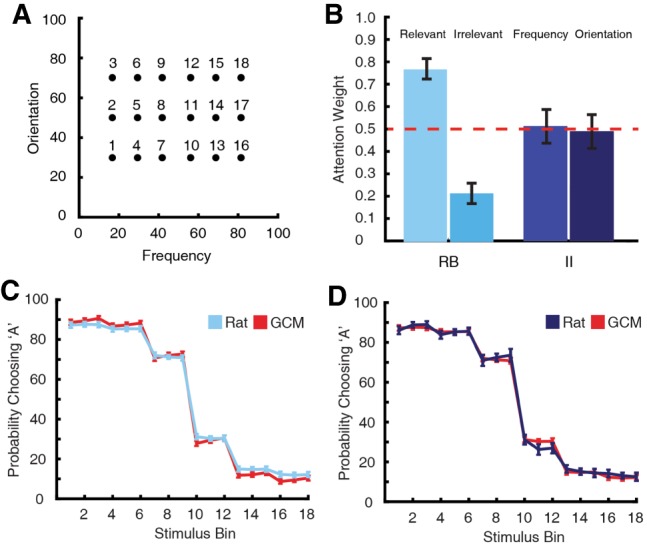
The GCM was fit to the generalization data of Experiment 1. (A) First, the testing distributions were averaged into 18 stimulus bins. This included three bins per trial type and nine bins per category. For each bin, the proportion of trials the rat responded category “A” was calculated. (B) The estimated attention weights obtained from the GCM fits. RB rats allocated more attention to the relevant stimulus dimension than the irrelevant dimension, whereas II rats split attention evenly between the two stimulus dimensions. (C,D) Comparison between rat's generalization behavior and GCM's predictions for RB rats (C) and II rats (D).